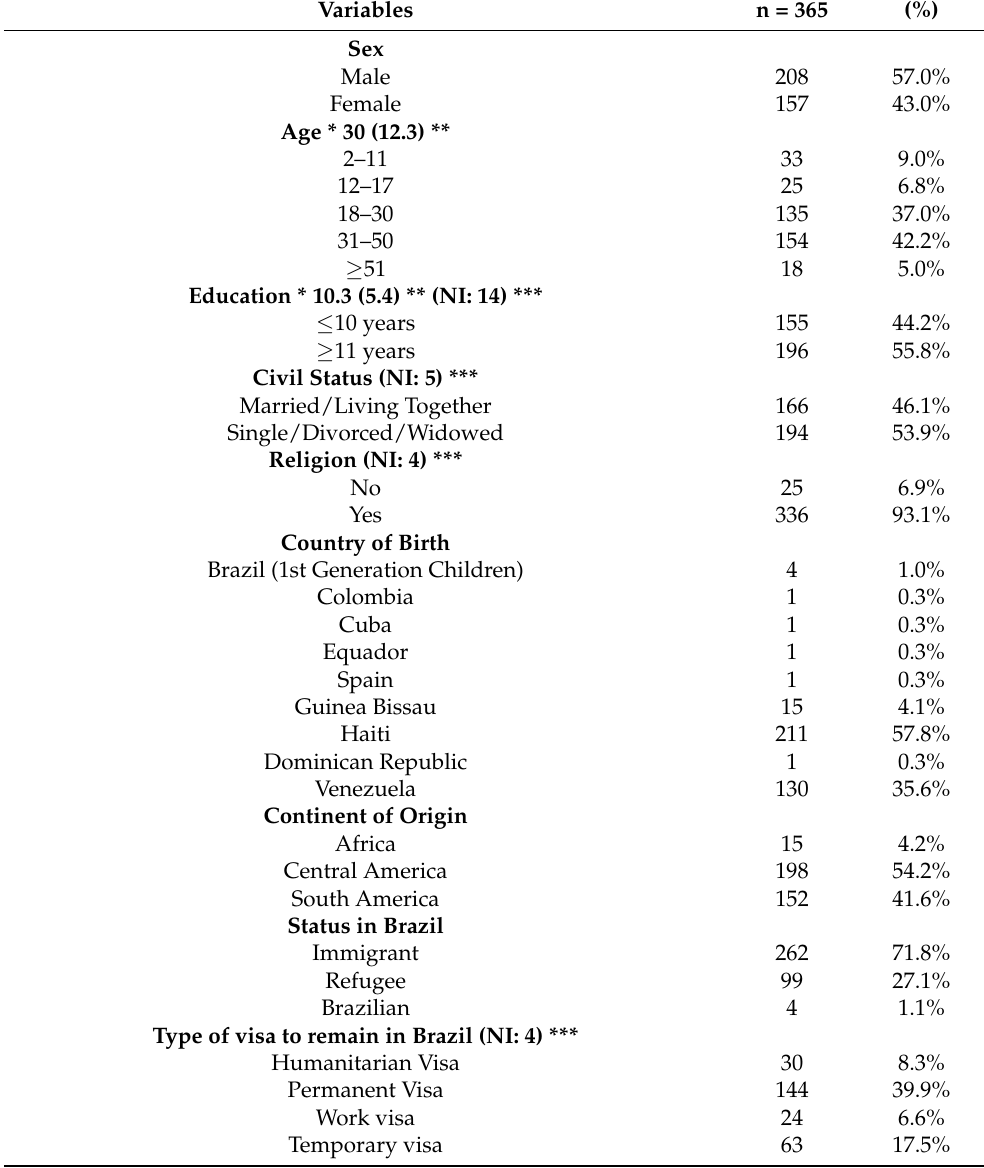
Table 1. Sociodemographic and immigration characteristics of 365 immigrants and refugees from the State of Goi á s, Brazil,